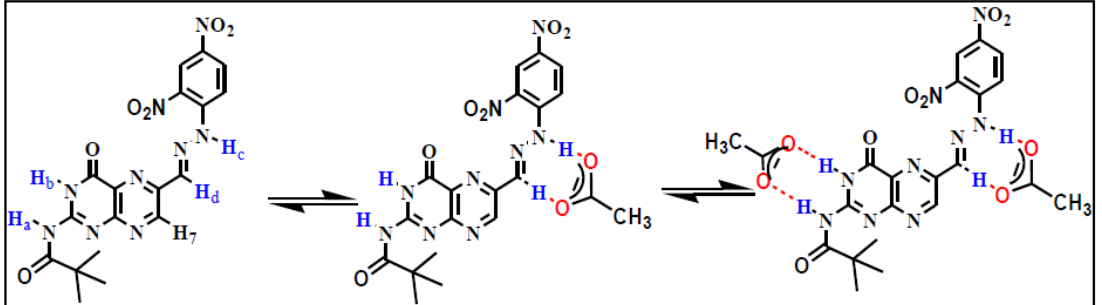
Figure 25: The bar plot of ratiometric response of R 34 in the presence of all the tested anions (left) and Plot of Absorbance vs. [AcO - ] at two different wave lengths (right). (adapted from 71e).